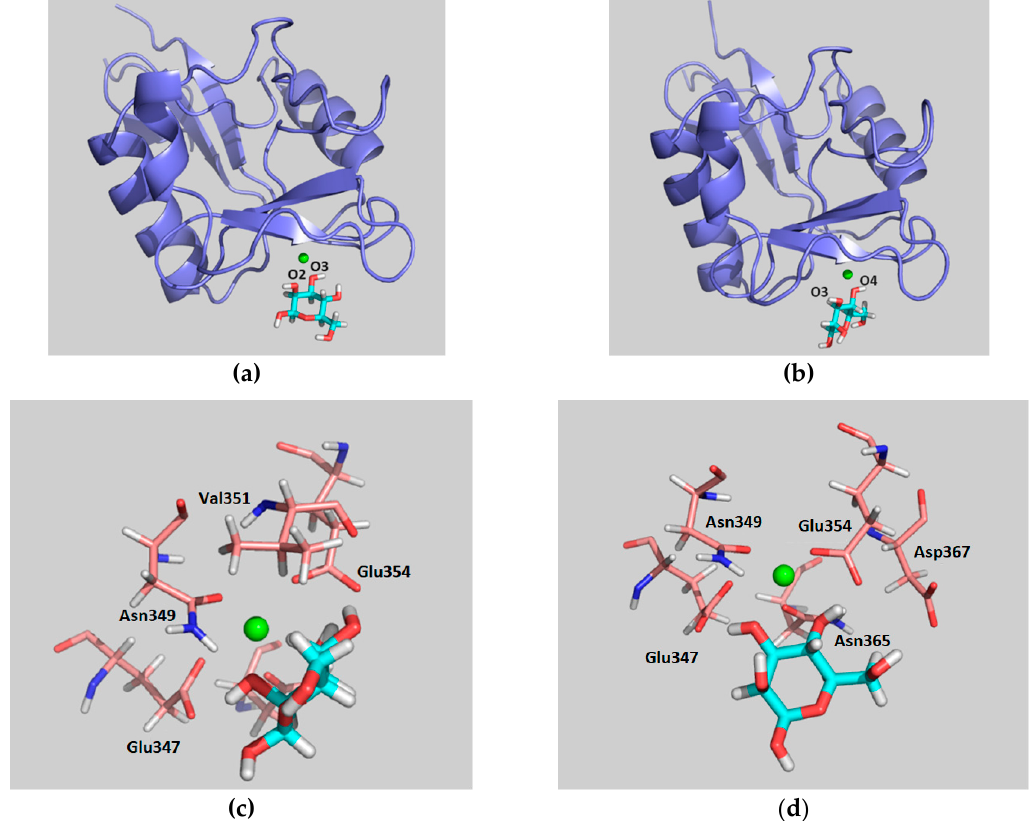
Figure 7. Snapshots from the molecular dynamics (MD) simulation of β - D -Man/DC-SIGN complex using pose A as the starting geometry. The general view is presented at the top panels, while expansions of the binding site are shown at the bottom panels. Panels ( a ) and ( c ) show Man (blue) in binding pose A. Panels ( b ) and ( d ) show Man in the binding pose of the X-ray crystal structures. Both binding modes are found during the MD simulations, regardless of the selected starting pose.